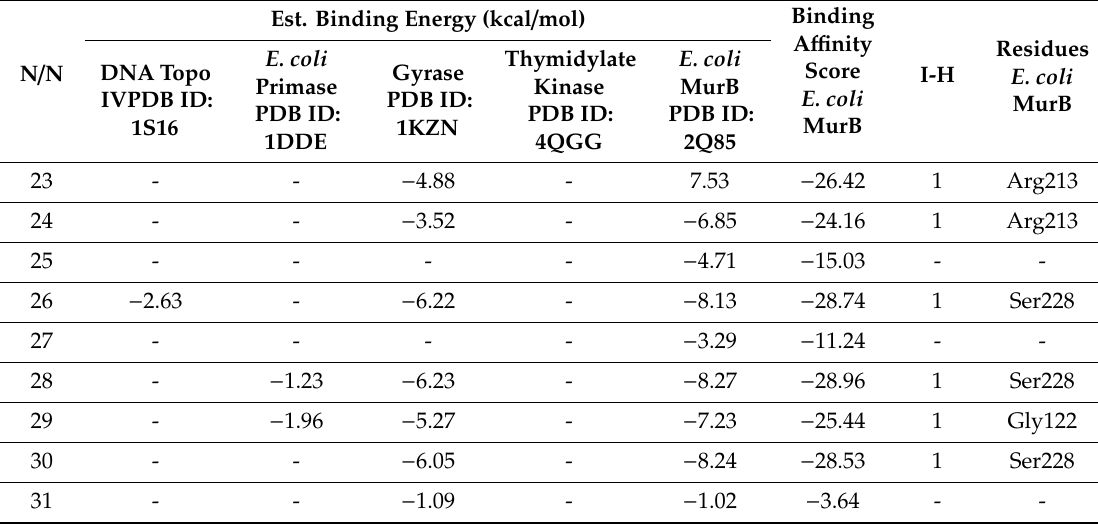
Table 6. Molecular docking binding affinities.